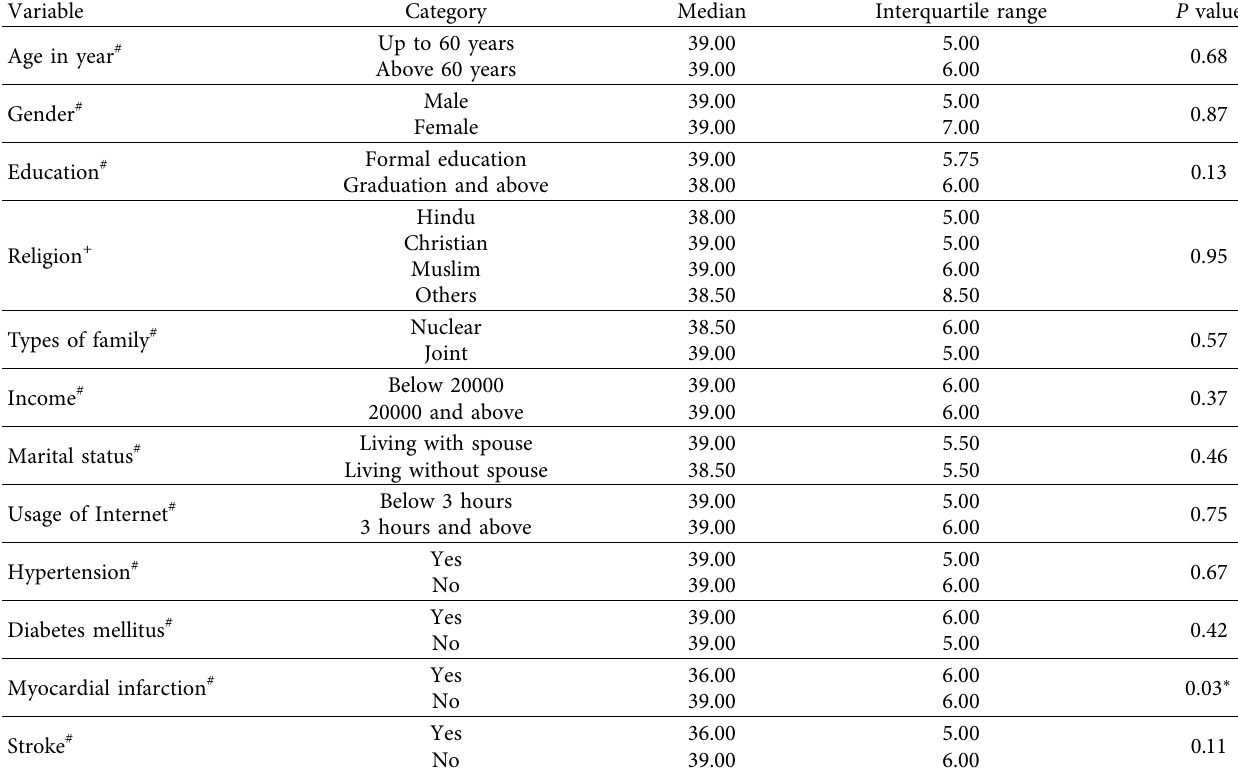
Table 4: Association between cyberchondriasis severity scale and various factors.